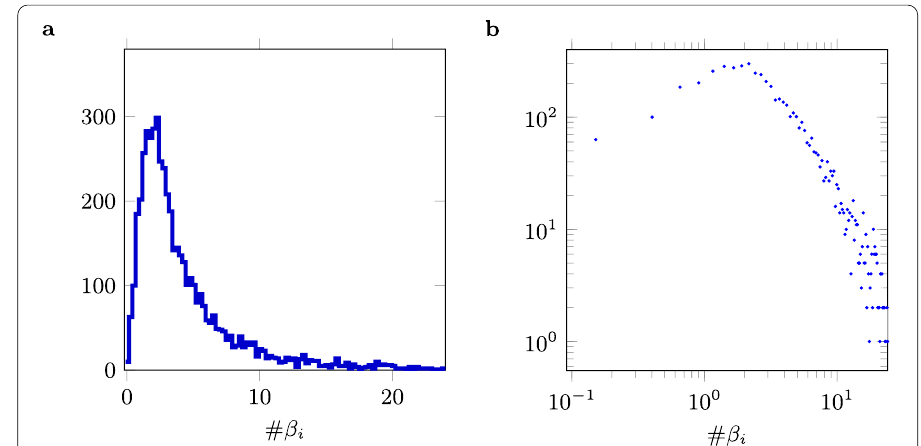
Fig. 10 a the empirical histogram of β i ( n ) and b its log-log variant, obtained by simulation of the Barabási– Albert model with m = 4 , the size of network is n =